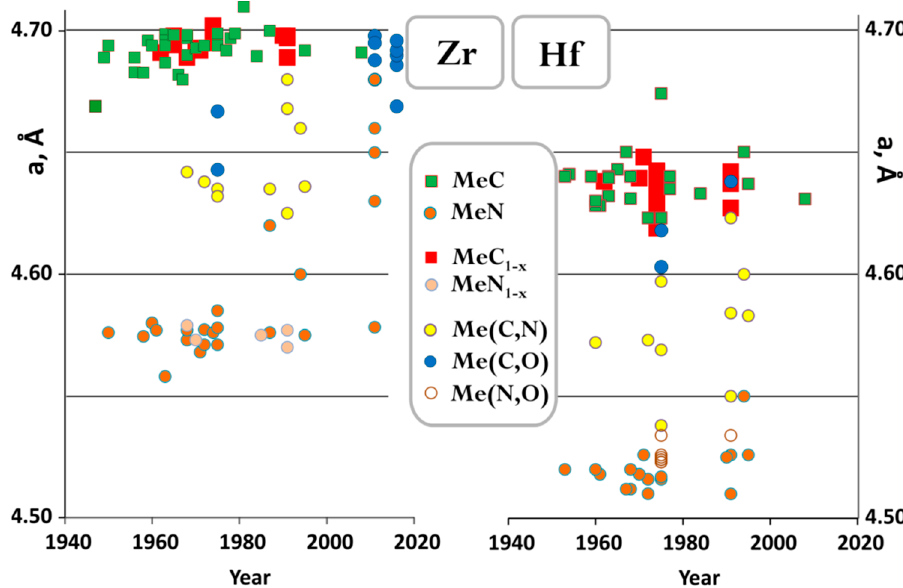
Figure 4. The lattice parameter of NaCl-type compounds. ( Left ) Hf-C-N-O system. ( Right ) Zr-C-N-O system. See Table S2 for compositions for each data point.